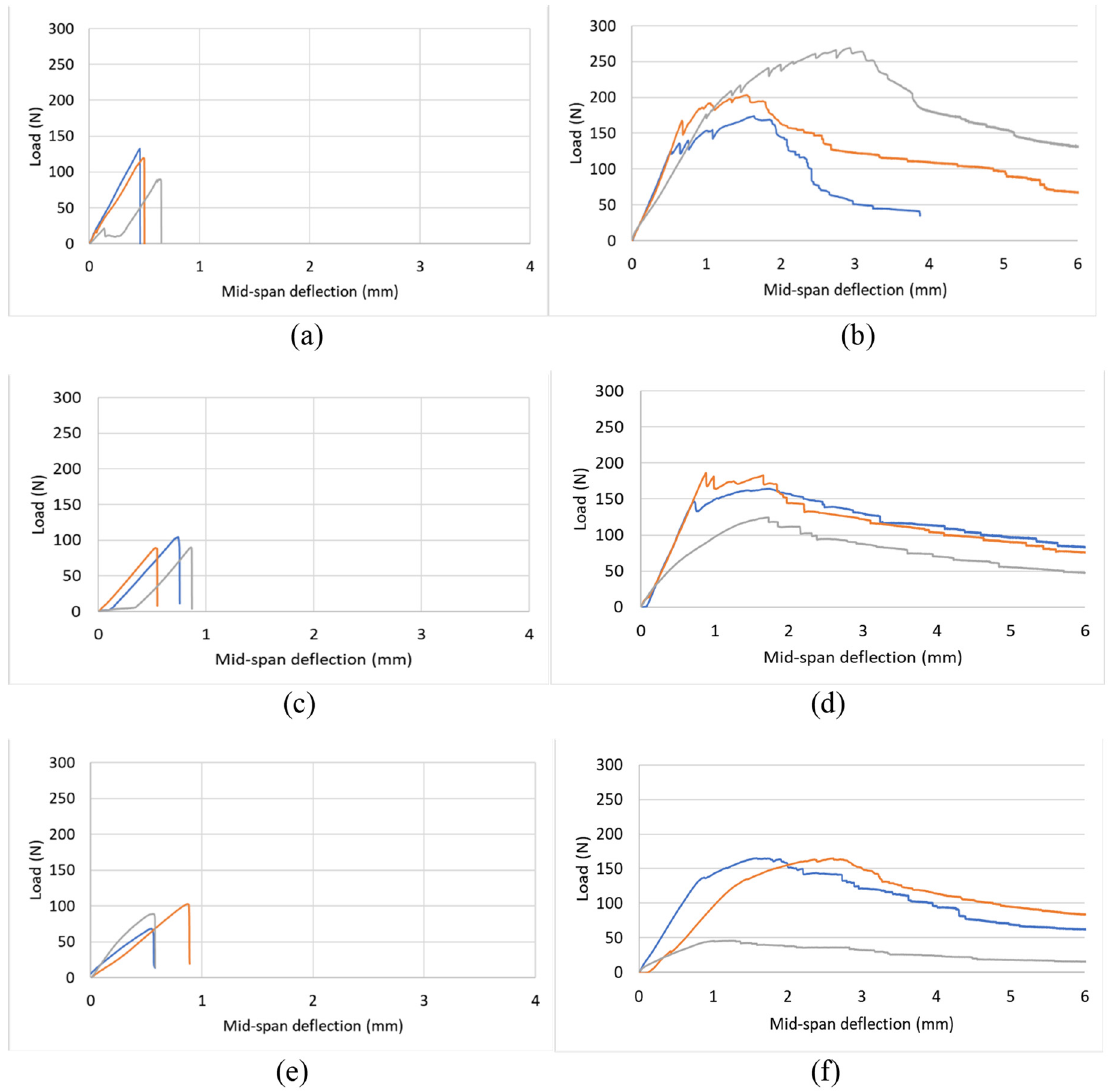
Figure 7. Flexural load vs. midspan deflection ( a ) UCC at ambient temperature (28 ◦ C) ( b ) RCC at ambient temperature (28 ◦ C) ( c ) UCC at 200 ◦ C ( d ) RCC at 200 ◦ C ( e ) UCC at 400 ◦ C ( f ) RCC at 400 ◦ C.